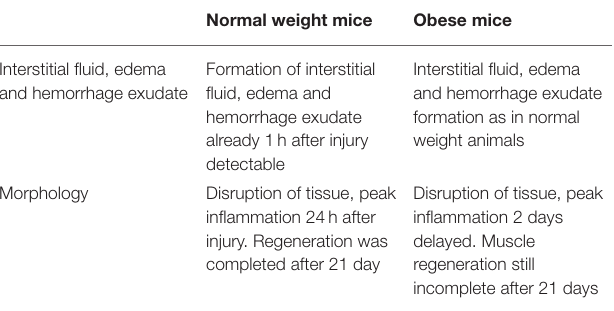
TABLE 3 | Blunt muscle injury to extensor iliotibialis anticus results in similar muscle damage but to an increased fibrosis formation in obese mice compared to normal weight